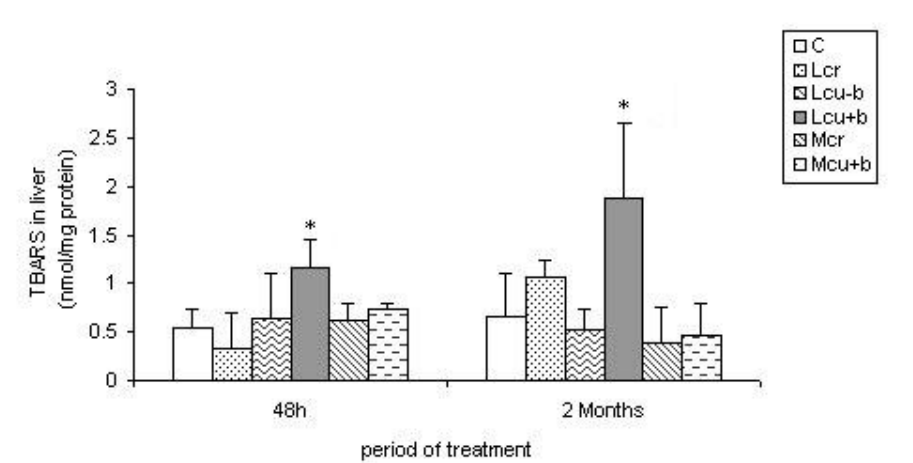
Figure 4. Lipid peroxidation values in the liver of control and treated rats (Lcr, Lcu-b, Lcu+b, Mcr and Mcu+b). The values are expressed as mean ± SEM (n = 6). Significant levels observed are * p ≤ 0.05 compared with control group